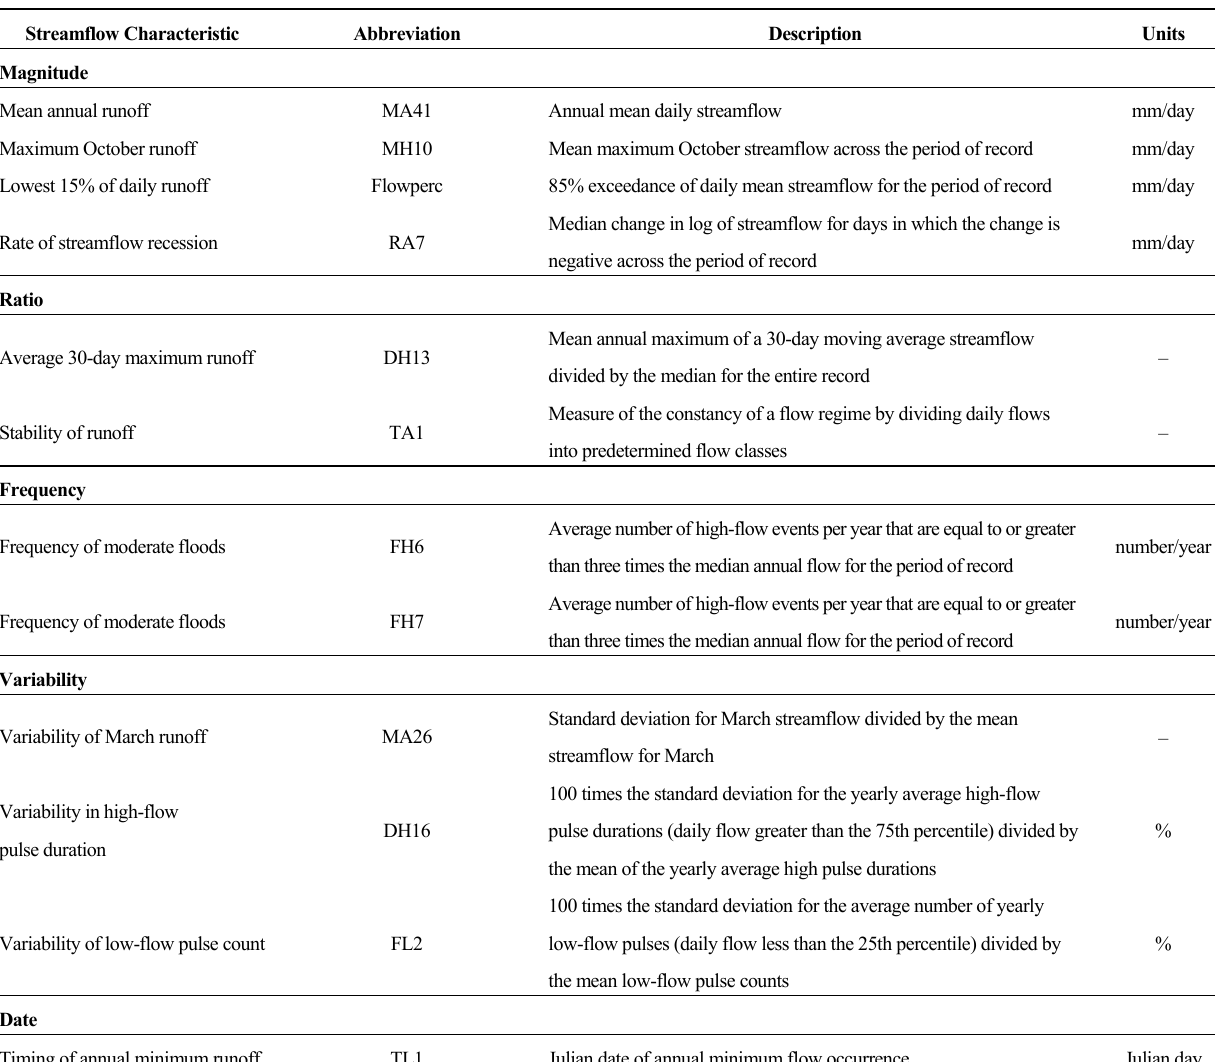
Table 5. Definition of streamflow characteristics used in this study (adapted and modified from Knight et al. , 2014 and Thomson and Archfield, 2014) (mm/day, millimeters per day; -, no units; %,